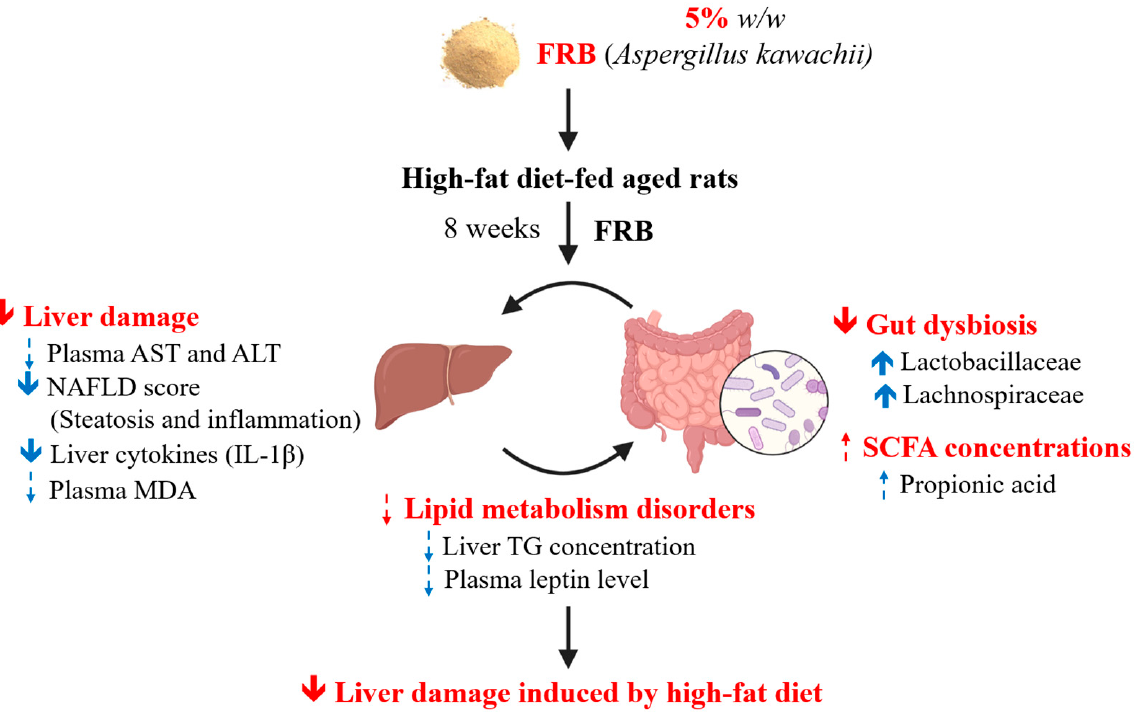
Figure 15. Effects of the water extract of fermented rice bran (FRB) on liver damage and intestinal injury in aged rats with high-fat (HF) diet feeding. In this study, it was indicated that FRB ameliorated liver damage induced by the HF diet which was represented as a lower non-alcoholic fatty liver disease (NAFLD) score and hepatic interleukin (IL)-1 β level in rats. The protective effects of FRB against liver damage may have been due to regulating the plasma adipokines and maintaining homeostasis of the gut microbiota. Solid blue arrow: levels of analytical items were significantly increased or decreased in the HF + 5% FRB group than in the HF group; dotted blue arrow: levels of analytical items in the HF + 5% FRB group showed an increasing or decreasing trend compared to the HF